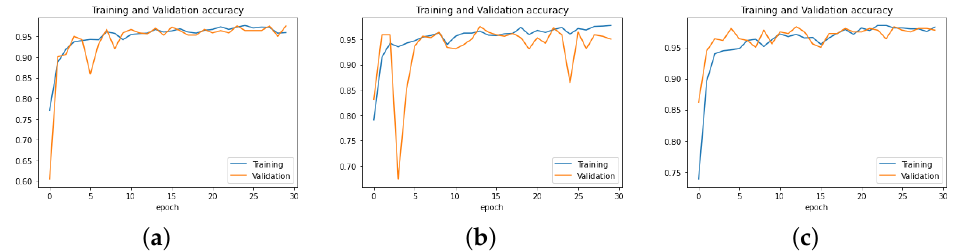
Figure 9. Performance of PNA-GCN with different data sizes. ( a ) Data size = 300 × 300 × 3. ( b ) Data size = 250 × 250 × 3. ( c ) Data size = 150 × 150 × 3.